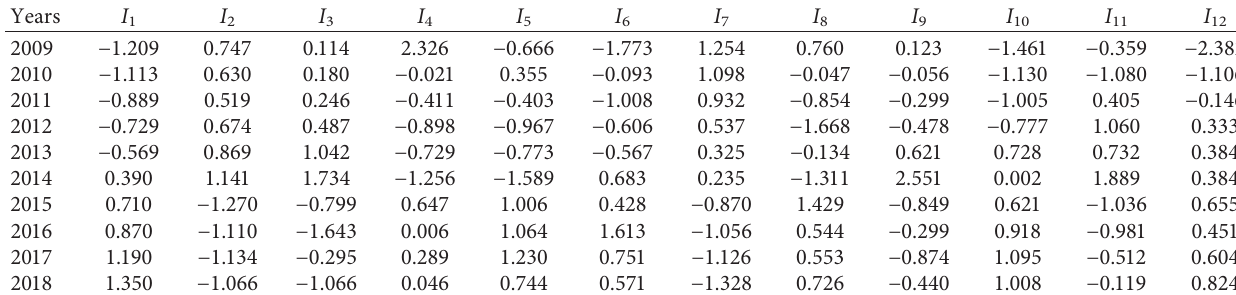
Table 4: Standardized data of each